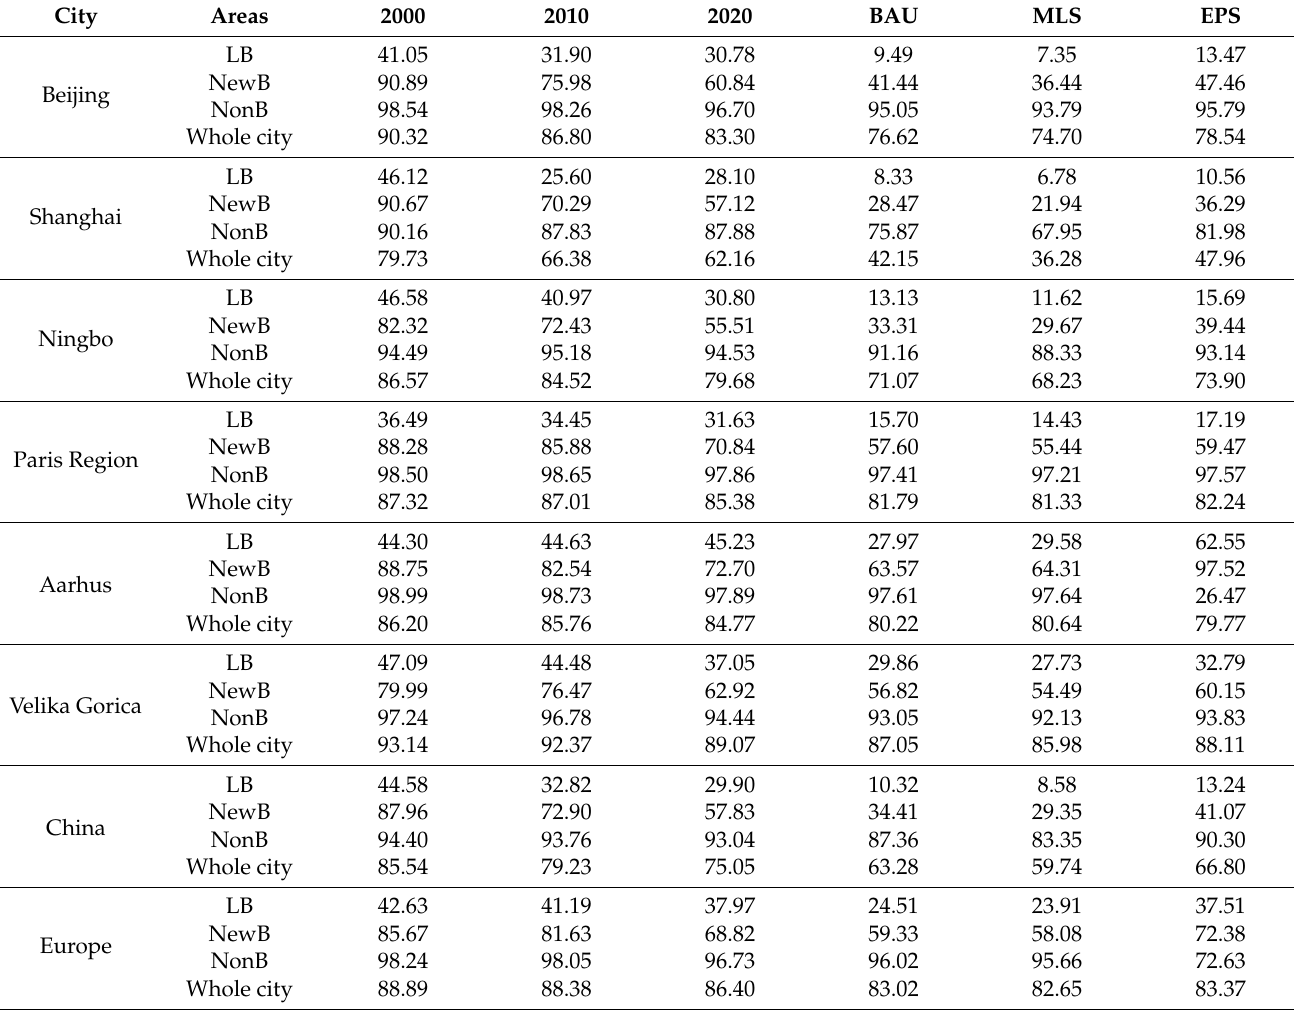
Table A4. Statistics of the GIF in different areas of each city from 2000 to 2030. City